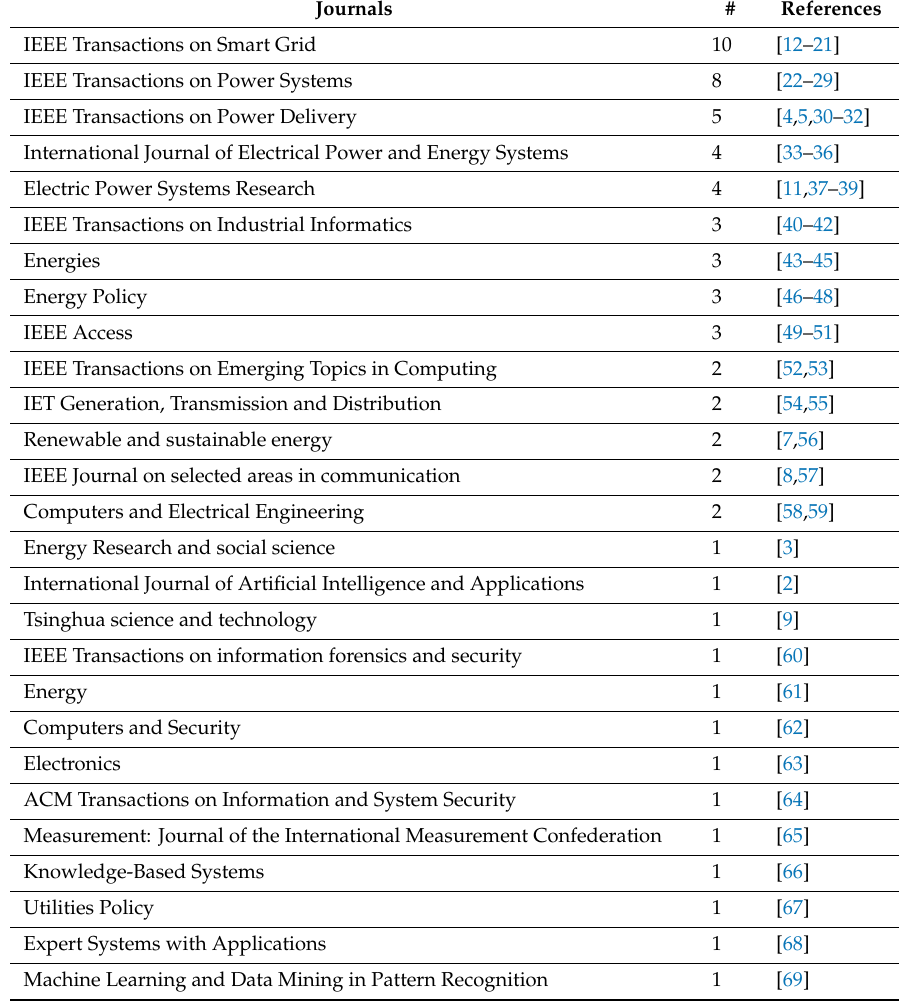
Table 1. Selected journals with a number of articles.